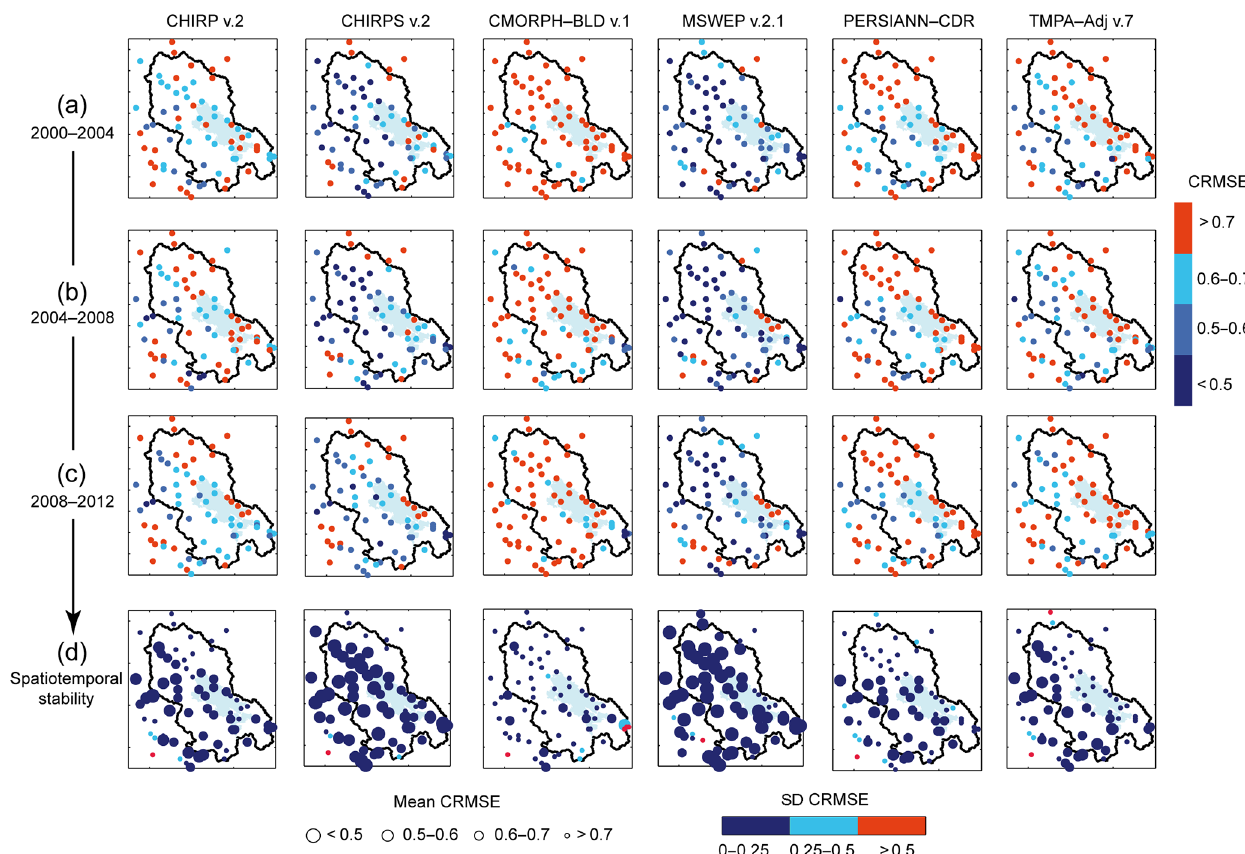
Figure 6. Consistency of SPPs in space and over time compared with gauge observations. CRMSE values obtained from the SPPs at the gauge level for three 4-year periods: (a) 2000–2004; (b) 2004–2008; and (c) 2008–2012. (d) Mean and SD CRMSE values obtained for each grid cell using the three respective values obtained for the three 4-year